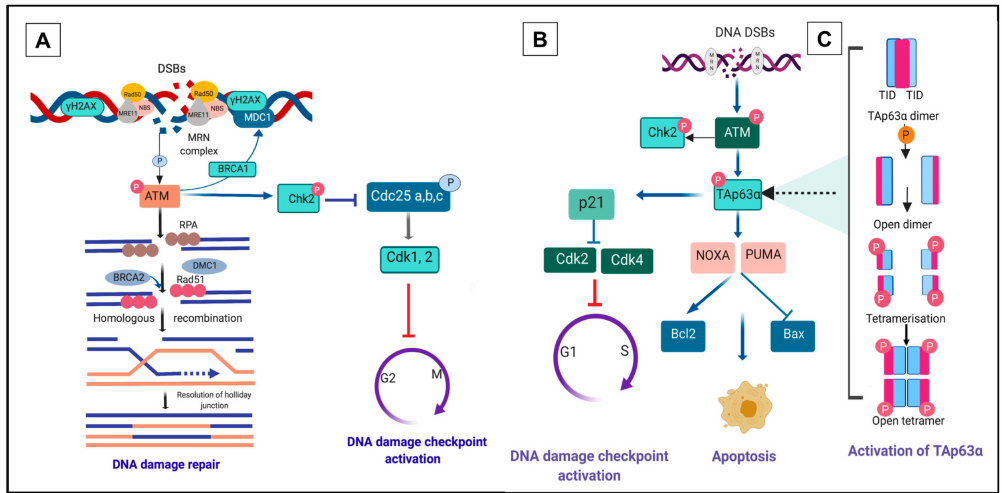
Figure 2. DNA double-strand breaks (DSBs) response pathway. ( A ) Homologous recombination (HR) repair pathway to combat DNA DSBs. Detection and recognition of DNA DSBs by the